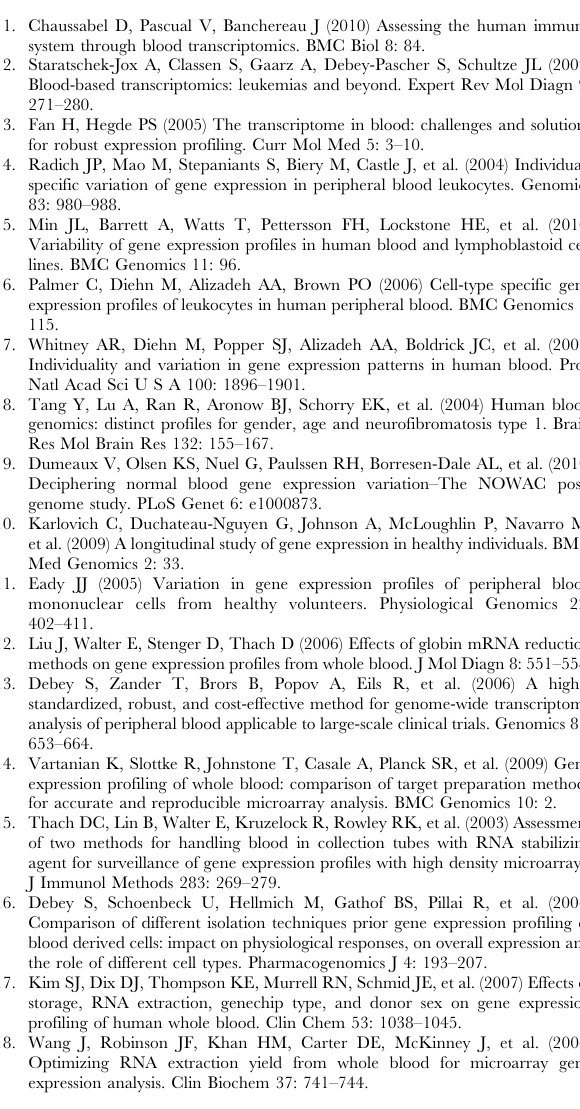
Figure S1 The ectopic expression patterns of XIST and RPS4Y1 in men and women. In x-axis, the samples were arranged in accordance with the array Series 1–3 from the left to the right. Black and red dots represent blood samples collected from men and women, respectively. The y-axis indicates the gene expression signal intensity. Table S1 Primers of selected genes for real-time PCR. Table S2 The proportion of total variation explained by each principle